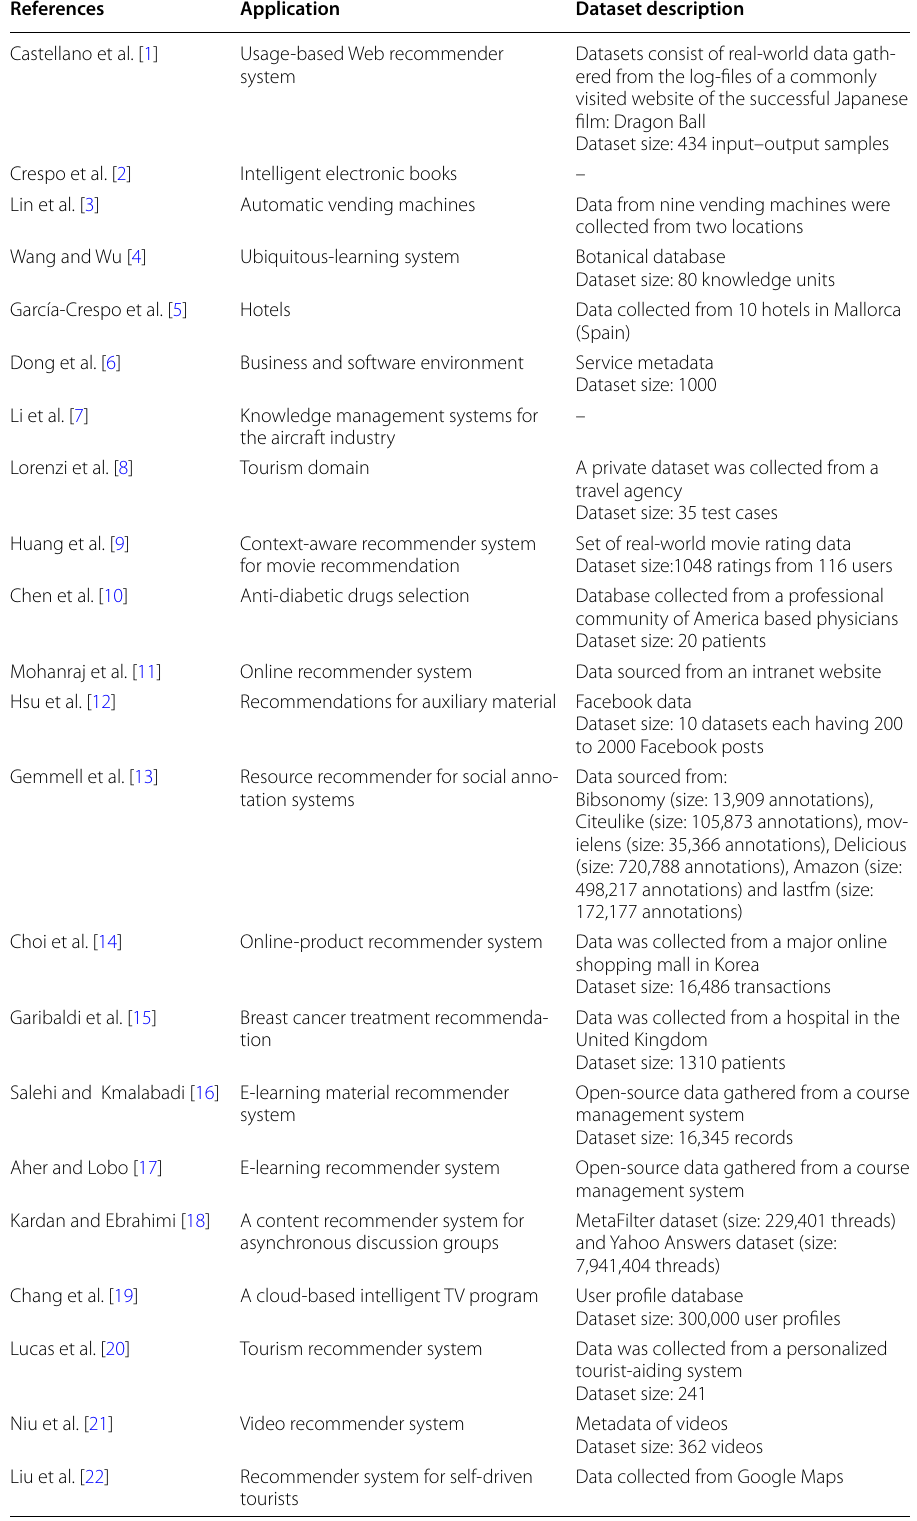
Table 8 Application focused and dataset description in different recommender